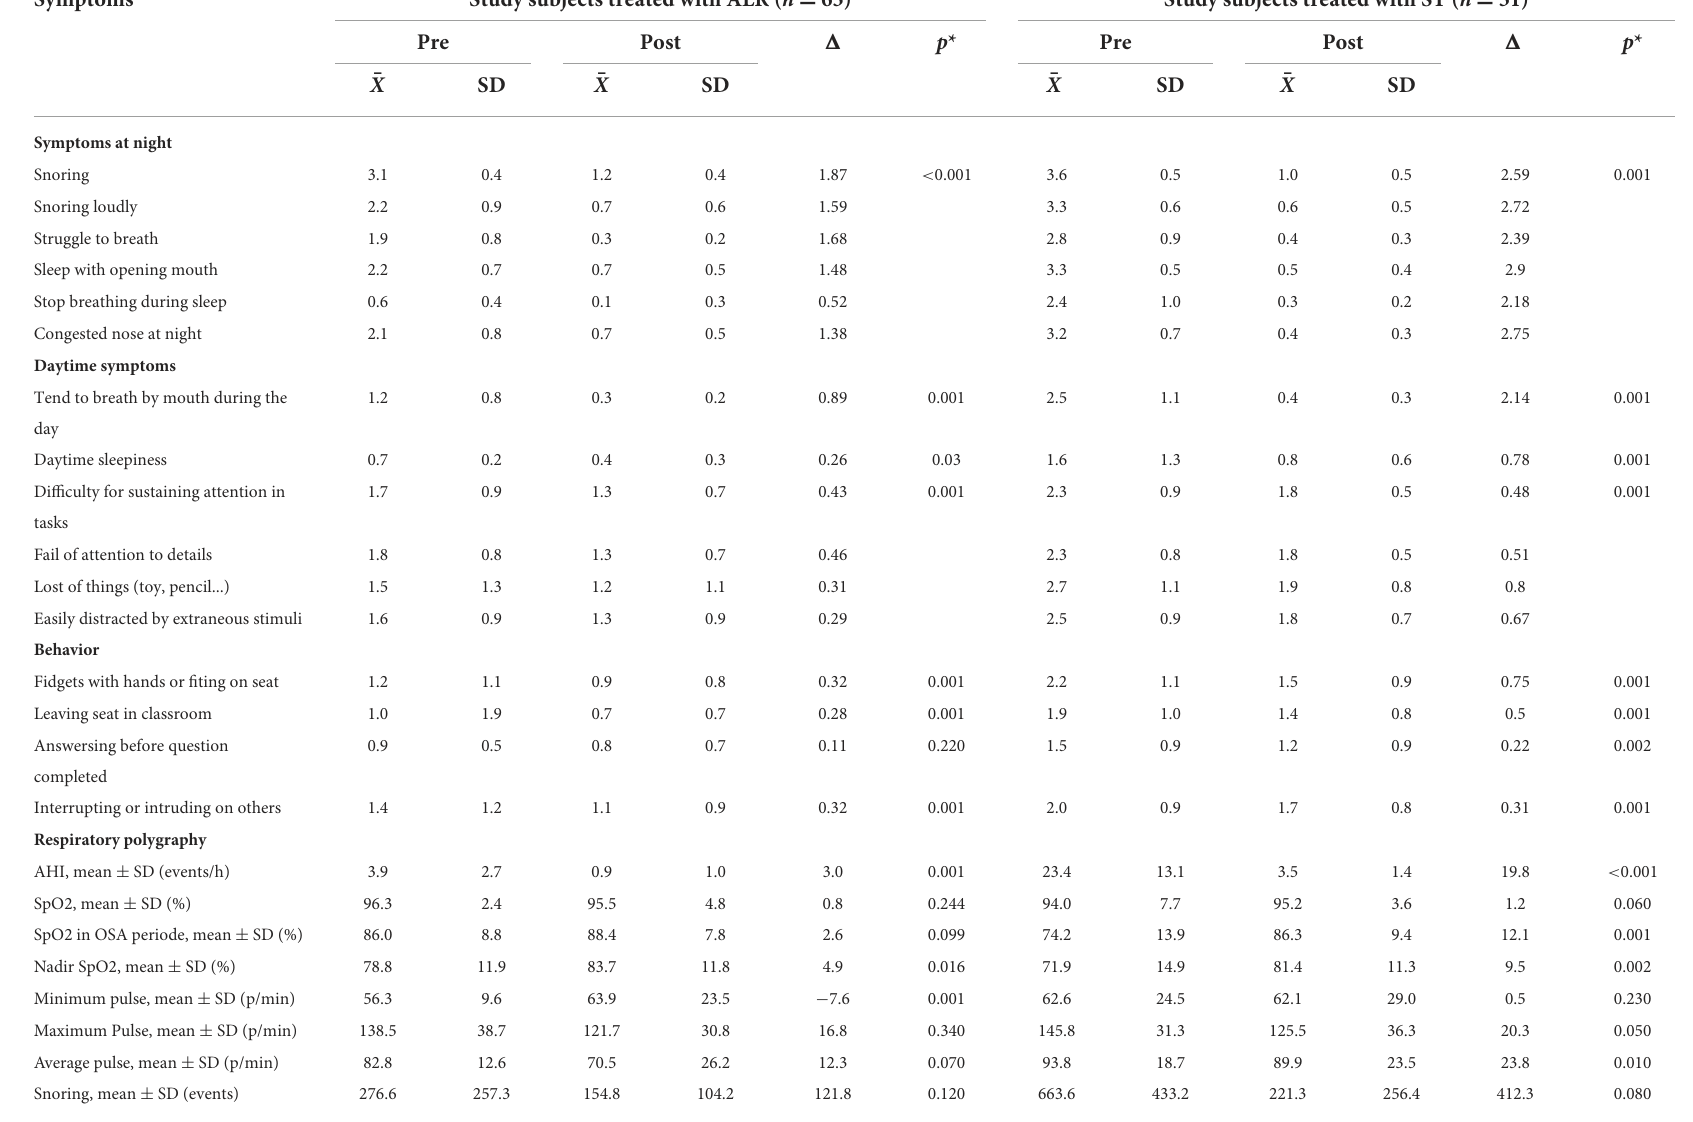
TABLE 3 Modification of clinical symptoms and respiratory polygraphy after treatment. Symptoms Study subjects treated with ALR ( n = 63) Study subjects treated with ST ( n = 51) Pre